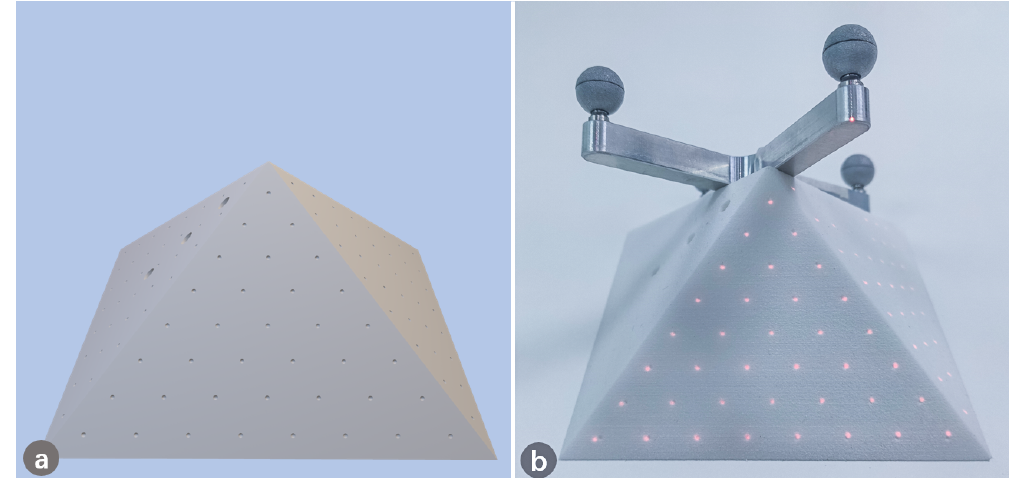
Figure 10. Points projected onto the 3D-printed pyramid for projection accuracy validation. ( a ) The designed pyramid with points; ( b ) Points were projected to overlap the pyramid.